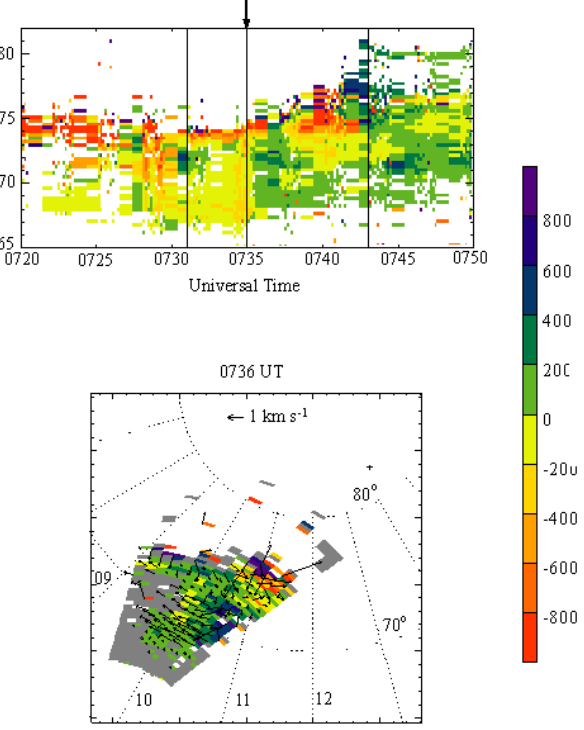
Fig. 5. Upper panel: Line-of-sight ion drift velocities obtained by beam 9 of the CUTLASS Finland HF radar during the interval 0720–0750 UT. Velocities are color-coded according to the scale to the right. Blue/dark green is toward (equatorward) and red is away (antisunward) from the radar. Onsets of auroral brightening and/or poleward expansion events are marked by vertical lines. Ar- row marks the onset of the event studied in this paper. Lower panel: Spatial plot of line-of-sight ion velocities within the total field of view of the CUTLASS radar for 0736 UT plotted in an MLT/MLAT reference system. Ion drift vectors obtained by a beam-swinging technique are